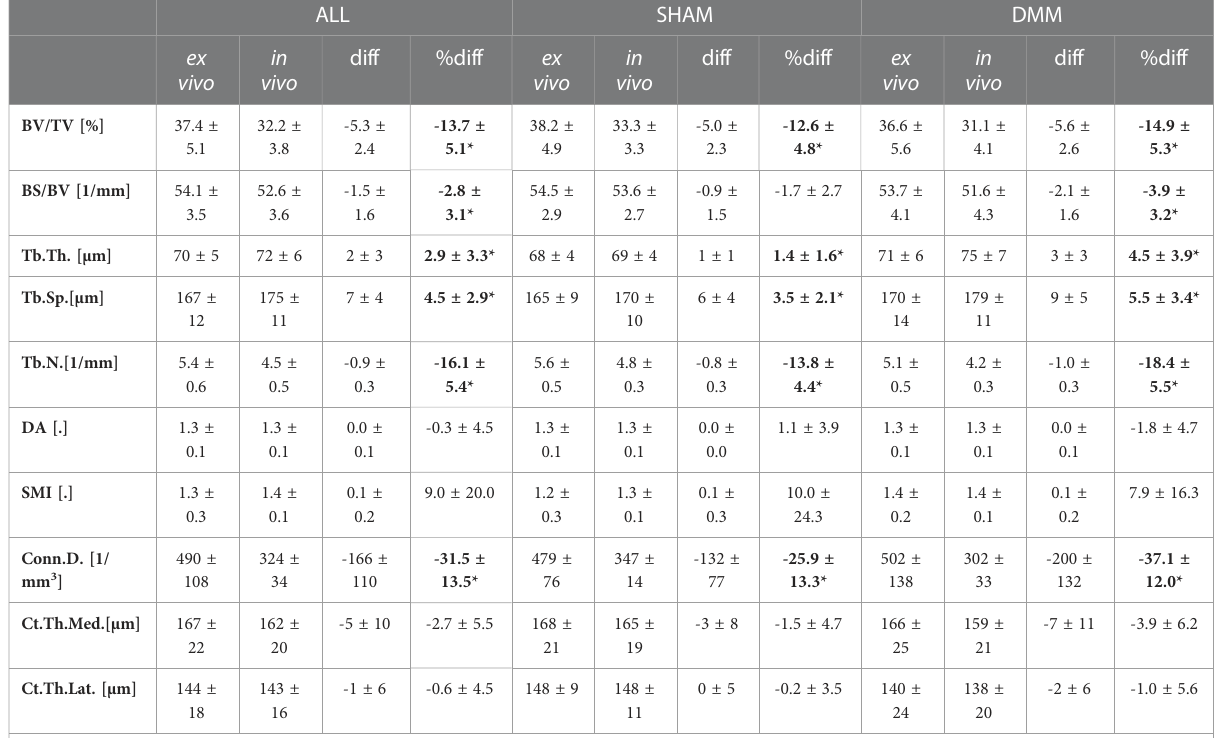
Differences are reported as average ± SD. *signi fi cant differences (p<0.05). In bold values that were found to be signi fi cantly different.